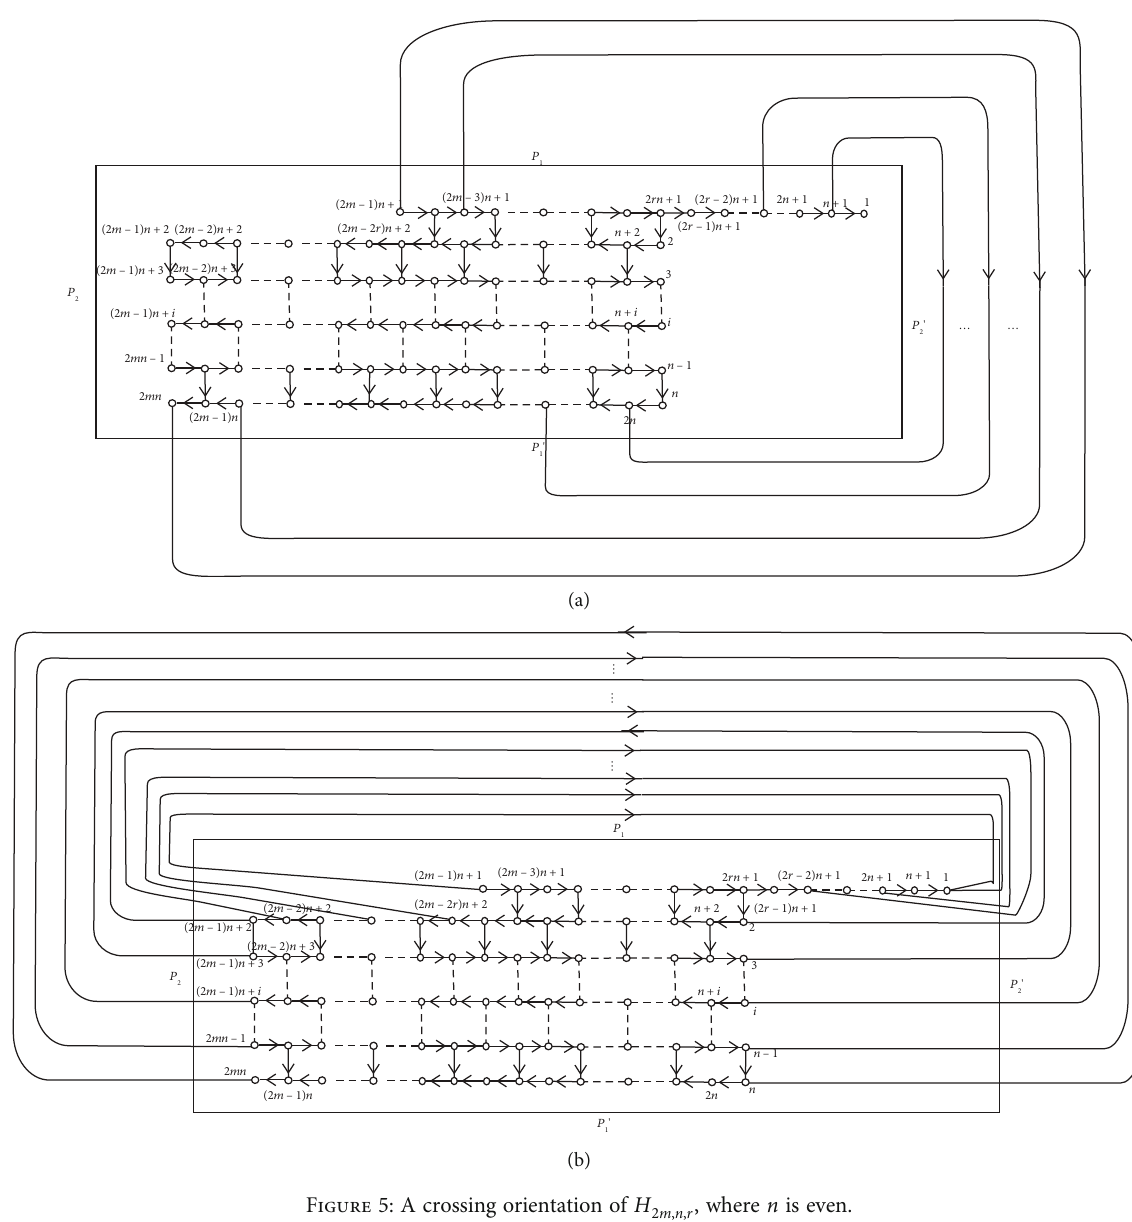
, where n is 2 m , n , r